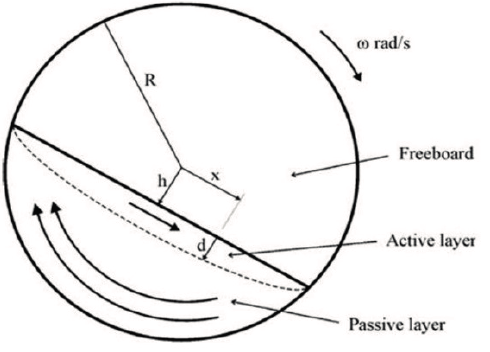
Figure 3. Schematic cross section of a rotary kiln drum, indicating the distribution of active and passive regions in relation to the bed and freeboard (adapted from